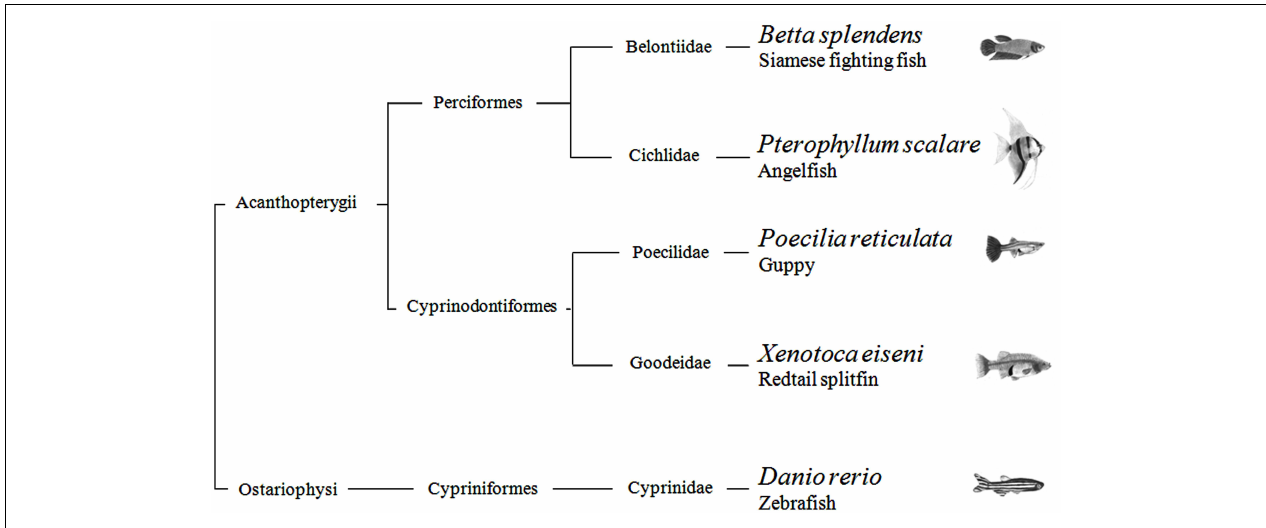
FIGURE 5 | Phylogenetic relationship of the five teleost species used in the